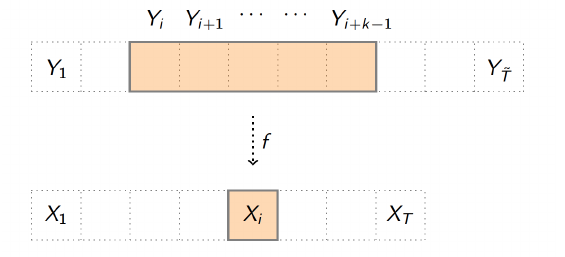
Figure 1. The block factor model.